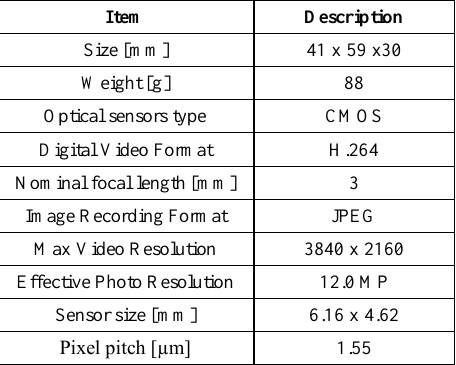
Table 1. Technical specification of GoPro 4 hero